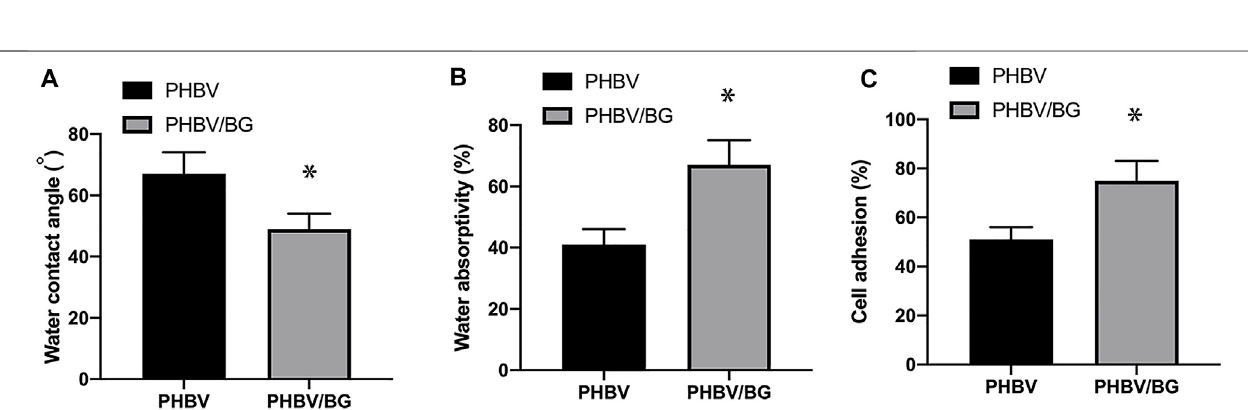
FIGURE 3 | Contact angle, water absorptivity, and cell adhesion of the scaffolds. (A) The water contact angles of the PHBV/Bioglass composite scaffolds were signi fi cantlylowerthanthatofthepurePHBVscaffold,indicatingthattherewasasigni fi cantincreaseinsurfacehydrophilicitywiththeadditionofBioglassintoPHBV( p < 0.05). (B) ThewaterabsorptivityofthePHBV/BioglasscompositescaffoldswasobviouslygreaterthanthatofpurePHBV( p < 0.05). (C) Thepercentageofadheredcells increased signi fi cantly with the addition of Bioglass ( p < 0.05).